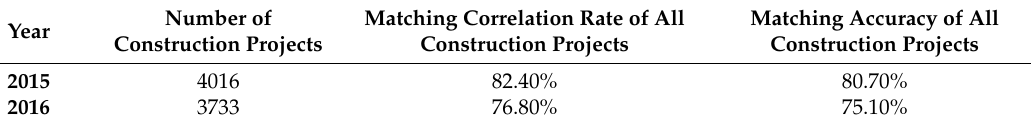
Table 9. The resulting general degrees of correlation for complete construction